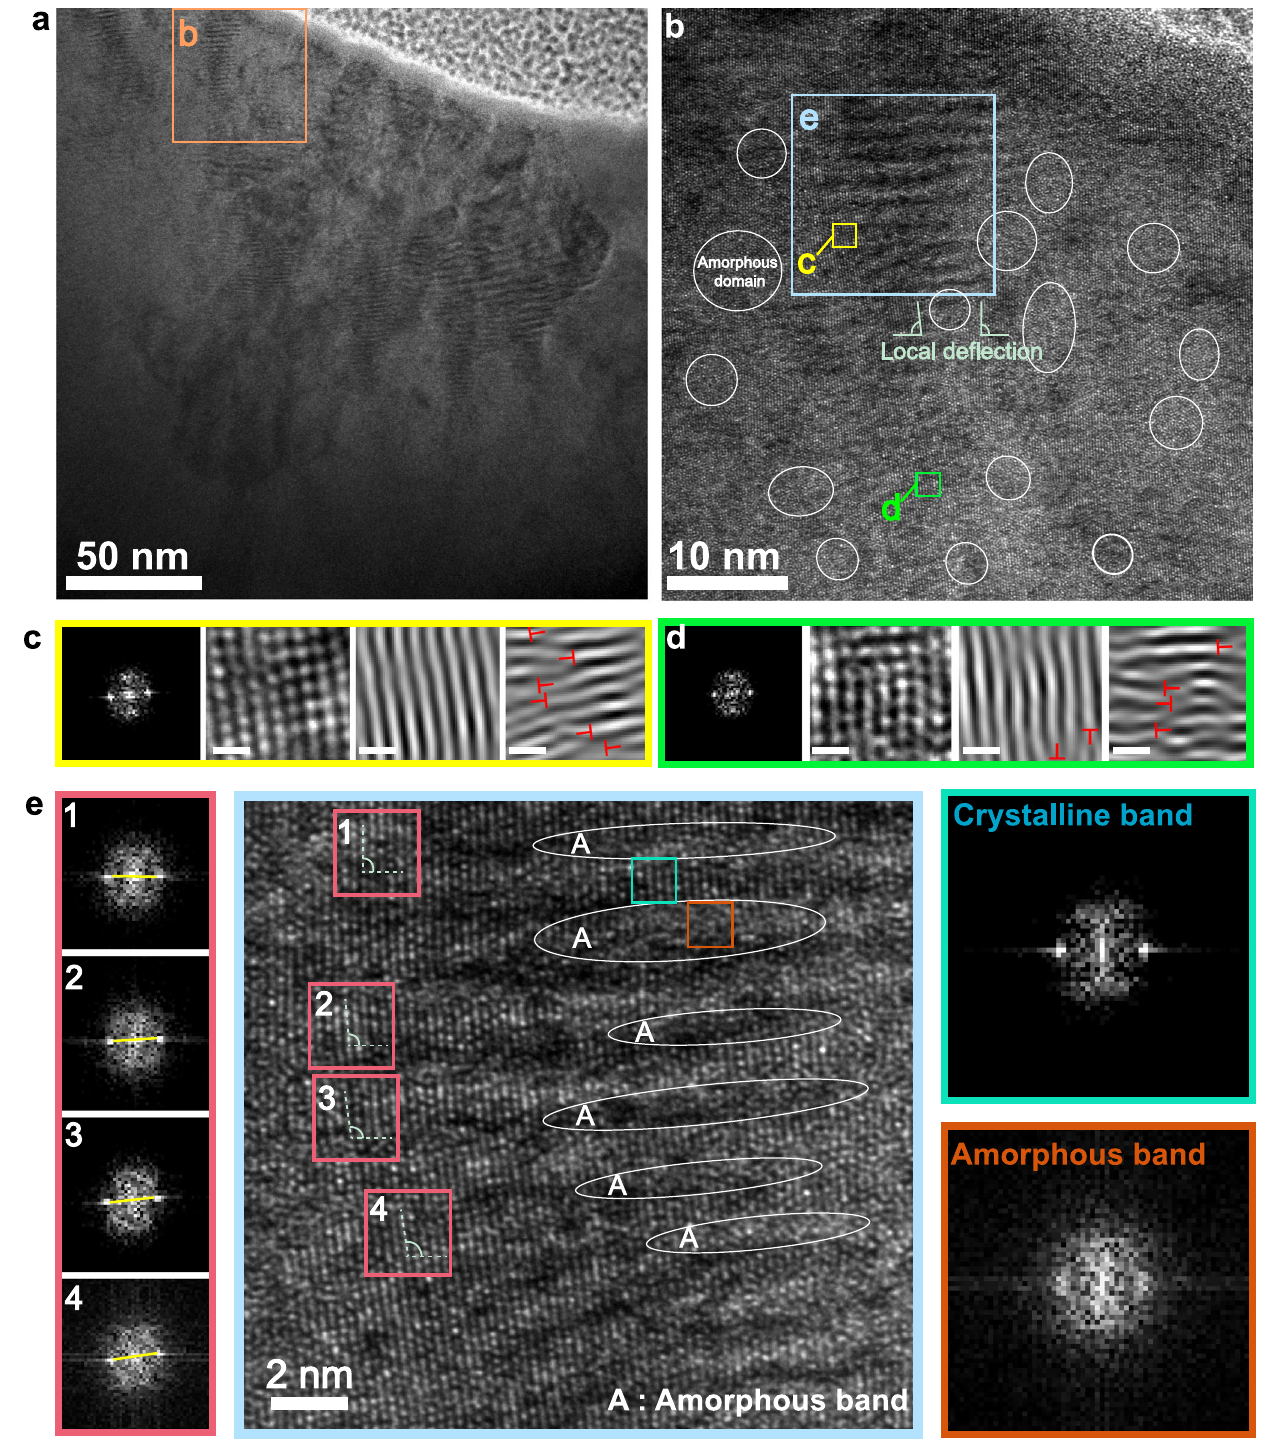
Fig. 4 | Microstructures of deformation region under indenter in the Zr 16 Nb 14 Hf 22 Ta 23 Mo 25 HEA.a TEMimagetakenfromthecross-sectionedindented region. b HRTEM image is taken from the orange square in ( a ) suggesting the existence of lamellar areas and amorphous domains. In addition, local de fl ections of crystalline lattice are induced by amorphous domains. c , d FFT pattern and the corresponding two-/one-dimensional inverse FFT images taken from the squared yellow and green area in ( b ), respectively, revealing the existence of numerous